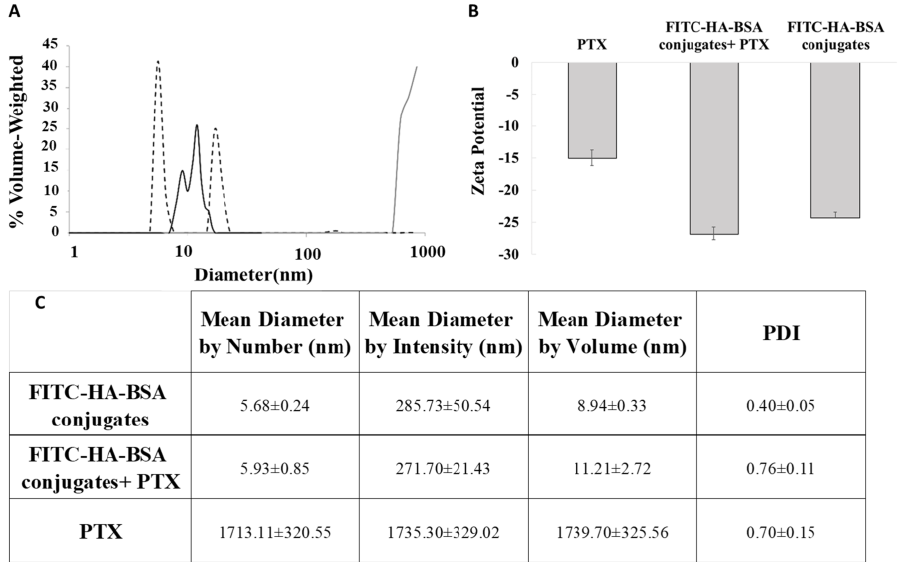
Figure 2. ( A ) Absorbance of FITC-HA-BSA conjugates (40 µ M; black solid line); of (80 µ M) PTX encapsulated in the conjugate NPs (dashed line), (PTX: FITC-HA-BSA conjugate molar ratio of 2:1), of pure PTX (80 µ M, gray solid line) and the absorbance summation of FITC-HA-BSA conjugates and PTX (dotted line); ( B ) Fluorescence quenching of HA-BSA by PTX as a function of PTX concentration. The excitation and emission were at 290 and 350 nm, respectively. The curve is a fit to a Langmuir-based model as described in Equation (2).